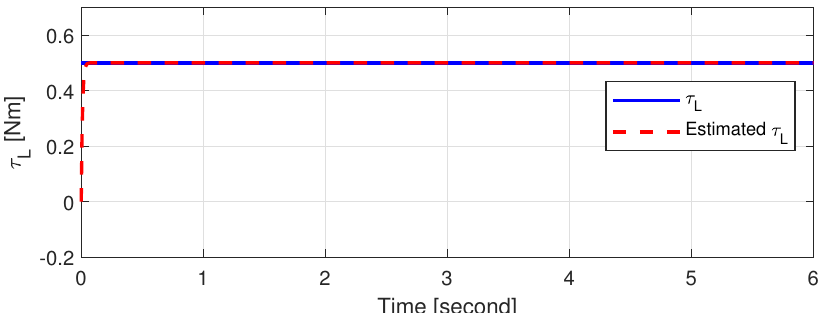
Figure 6. Load torque estimation performance of the nonlinear